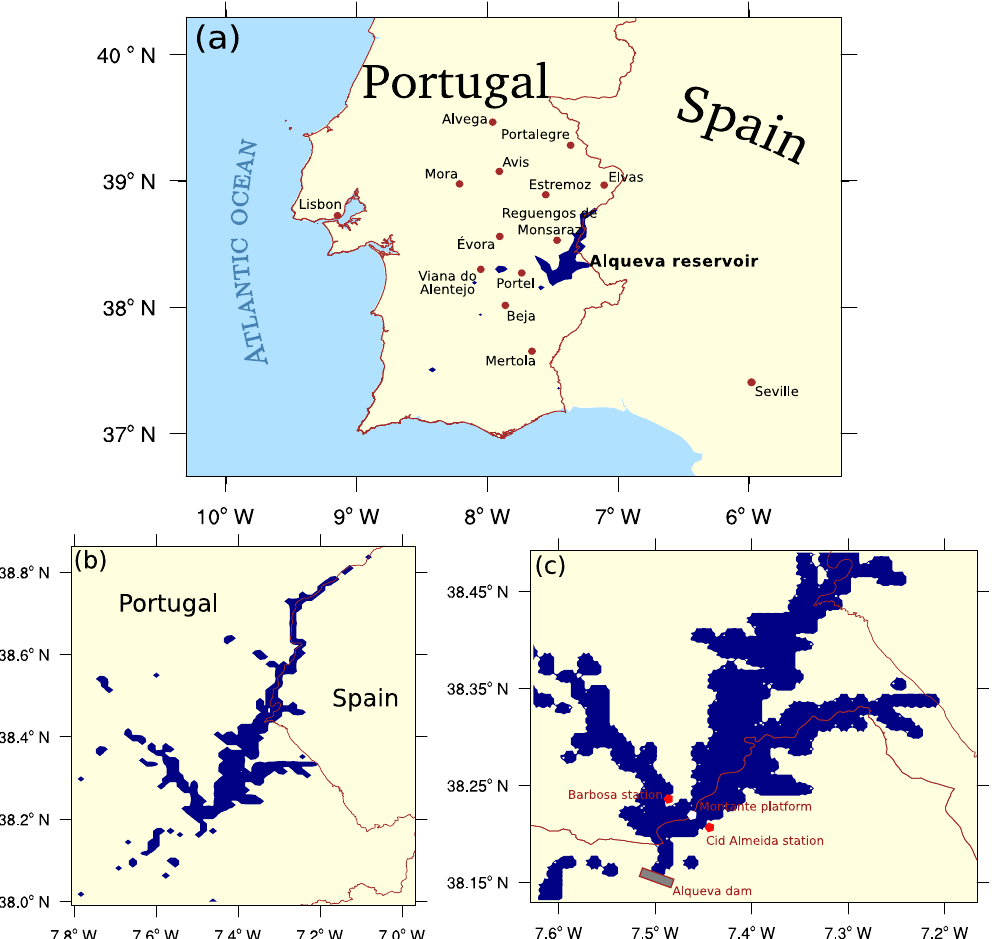
Figure 1. Nested domains used in the simulations: (a) the “father” domain at 4km horizontal resolution with 100 × 108 grid points, with location of the 12 IPMA synoptic stations used for validation; (b) intermediate 1km horizontal resolution domain, 96 × 72 grid points; (c) finer 250m resolution domain comprising 160 × 160 grid points, together with the location of the ALEX land stations, the Montante floating platform and the